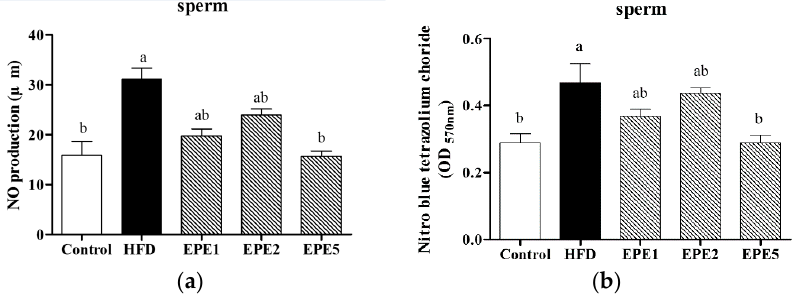
Figure 6. Effects of Echinacea purpurea ethanol extract on ( a ) nitric oxide production and ( b ) and nitroblue tetrazolium reduction in sperm of HFD-induced obese rats after 5 weeks. Data are shown as the mean ± S.E.M. ( n = 5). The values with different superscript letters ( a , b ) are significantly